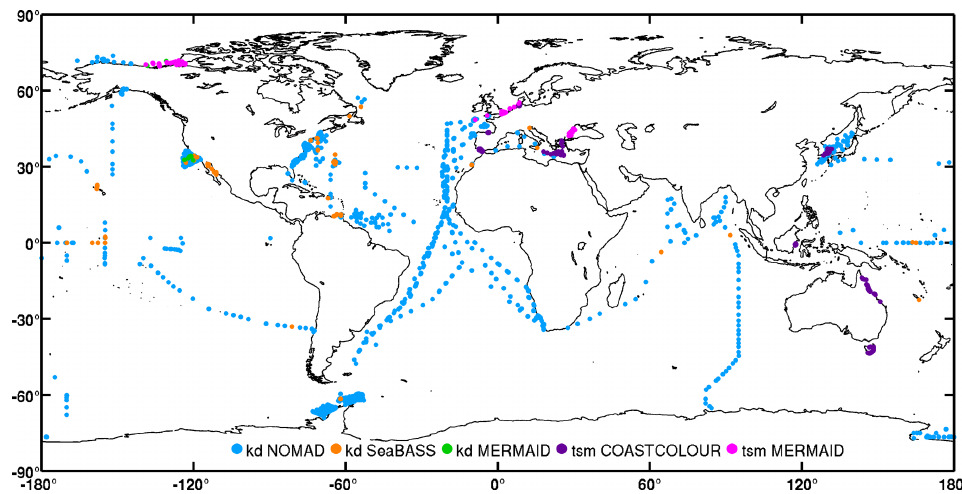
Figure 15. Global distribution of diffuse attenuation coefficient for downward irradiance (kd) and total suspended matter (tsm) per dataset in the final table. The tsm and kd points from MERMAID overlap each other in the western Black Sea ( ∼ 40 ◦ N, 30 ◦ E) and the Arctic ( ∼ 70 ◦ N, 120 ◦